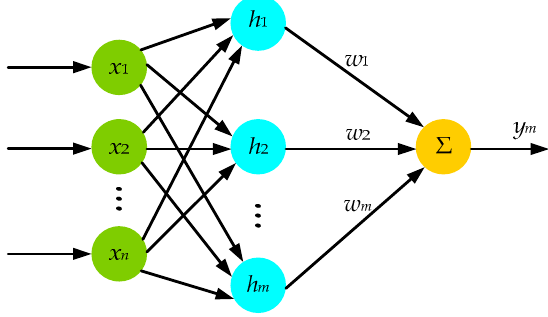
Figure 3. Topology of a radial basis function (RBF) neural network.